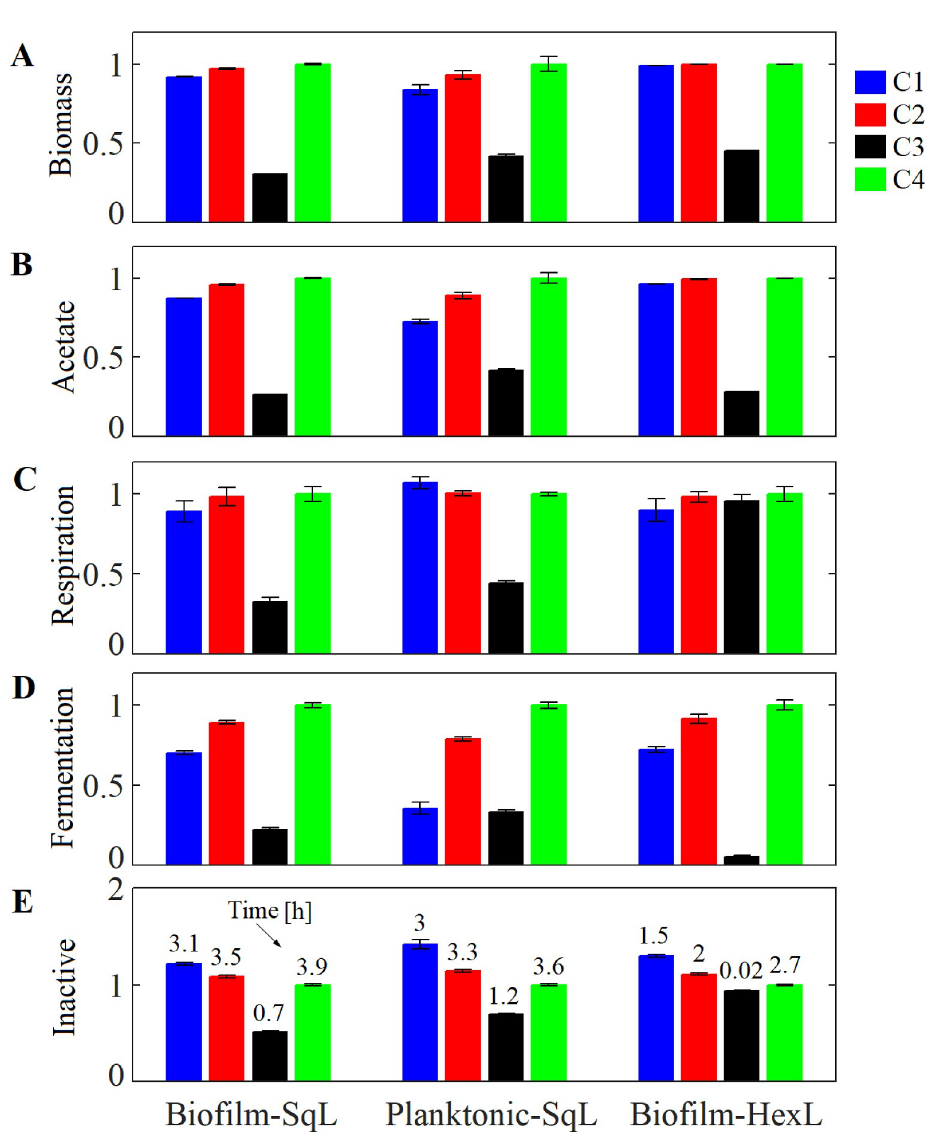
Fig 3. E . coli biofilm development at time 8.5 h with a glucose supply of 2.25 mM under different crowding assumptions. Three growth conditions and cell-packing configurations were tested: the biofilm growth using either a square lattice (Biofilm-SqL) or a hexagonal grid (Biofilm-HexL), and the planktonic mode of growth using a square lattice (Planktonic-SqL). (A) Relative biomass computed as Biomass(obtained in each C)/Biomass(obtained in C4) at time 8.5 h. (B) Relative acetate computed as Acetate(produced in each C)/Acetate(in C4). Relative number of cells identified with phenotype (C) respiration: glucose + O 2 ➔ (acetate) + biomass, (D) fermentation: glucose ➔ acetate + biomass, and (E) inactive cells in each C compared to those obtained in C4. The number showed on bar plot (E) indicate the time in [h] when inactive cells appeared in the system. Crowding assumptions C1-4 are described in Table 2. Error bars show the standard deviation in three independent